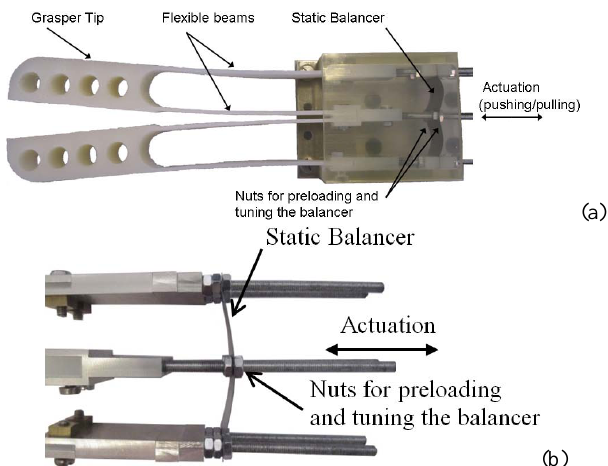
Figure 5. (a) Prototype of scaled up SBCG with (b) a detail of the tuning equilibrium positions using the